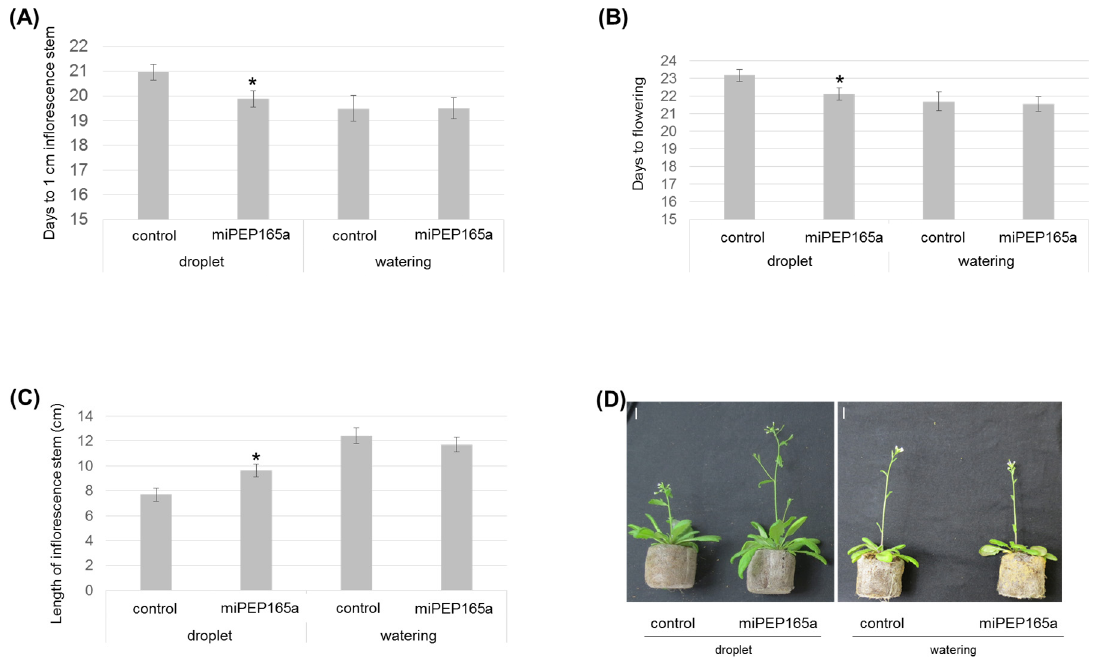
Figure 2. Flowering phenotypes of Arabidopsis plants in response to miPEP165a treatment. Arabidopsis plants were treated with either water (control) or a droplet of 100 µM miPEP165a placed on the shoot apical meristem or by watering with 10 µM miPEP165a three times a week until analyses. Flowering time measurements were determined using the number of days to obtain an inflorescence stem of 1 cm ( A ) and the number of days to obtain the first flowers ( B ). ( C ) The length of the Arabidopsis inflorescence stem was determined 24 days after sowing. Error bars indicate SEM. Statistical analysis was performed using a t -test ( p < 0.01). ( D ) Representative pictures showing the flowering phenotype according to the miPEP165a treatment. Experiments were performed at least 4 independent times ( n > 78 plants). Bar = 1 cm.